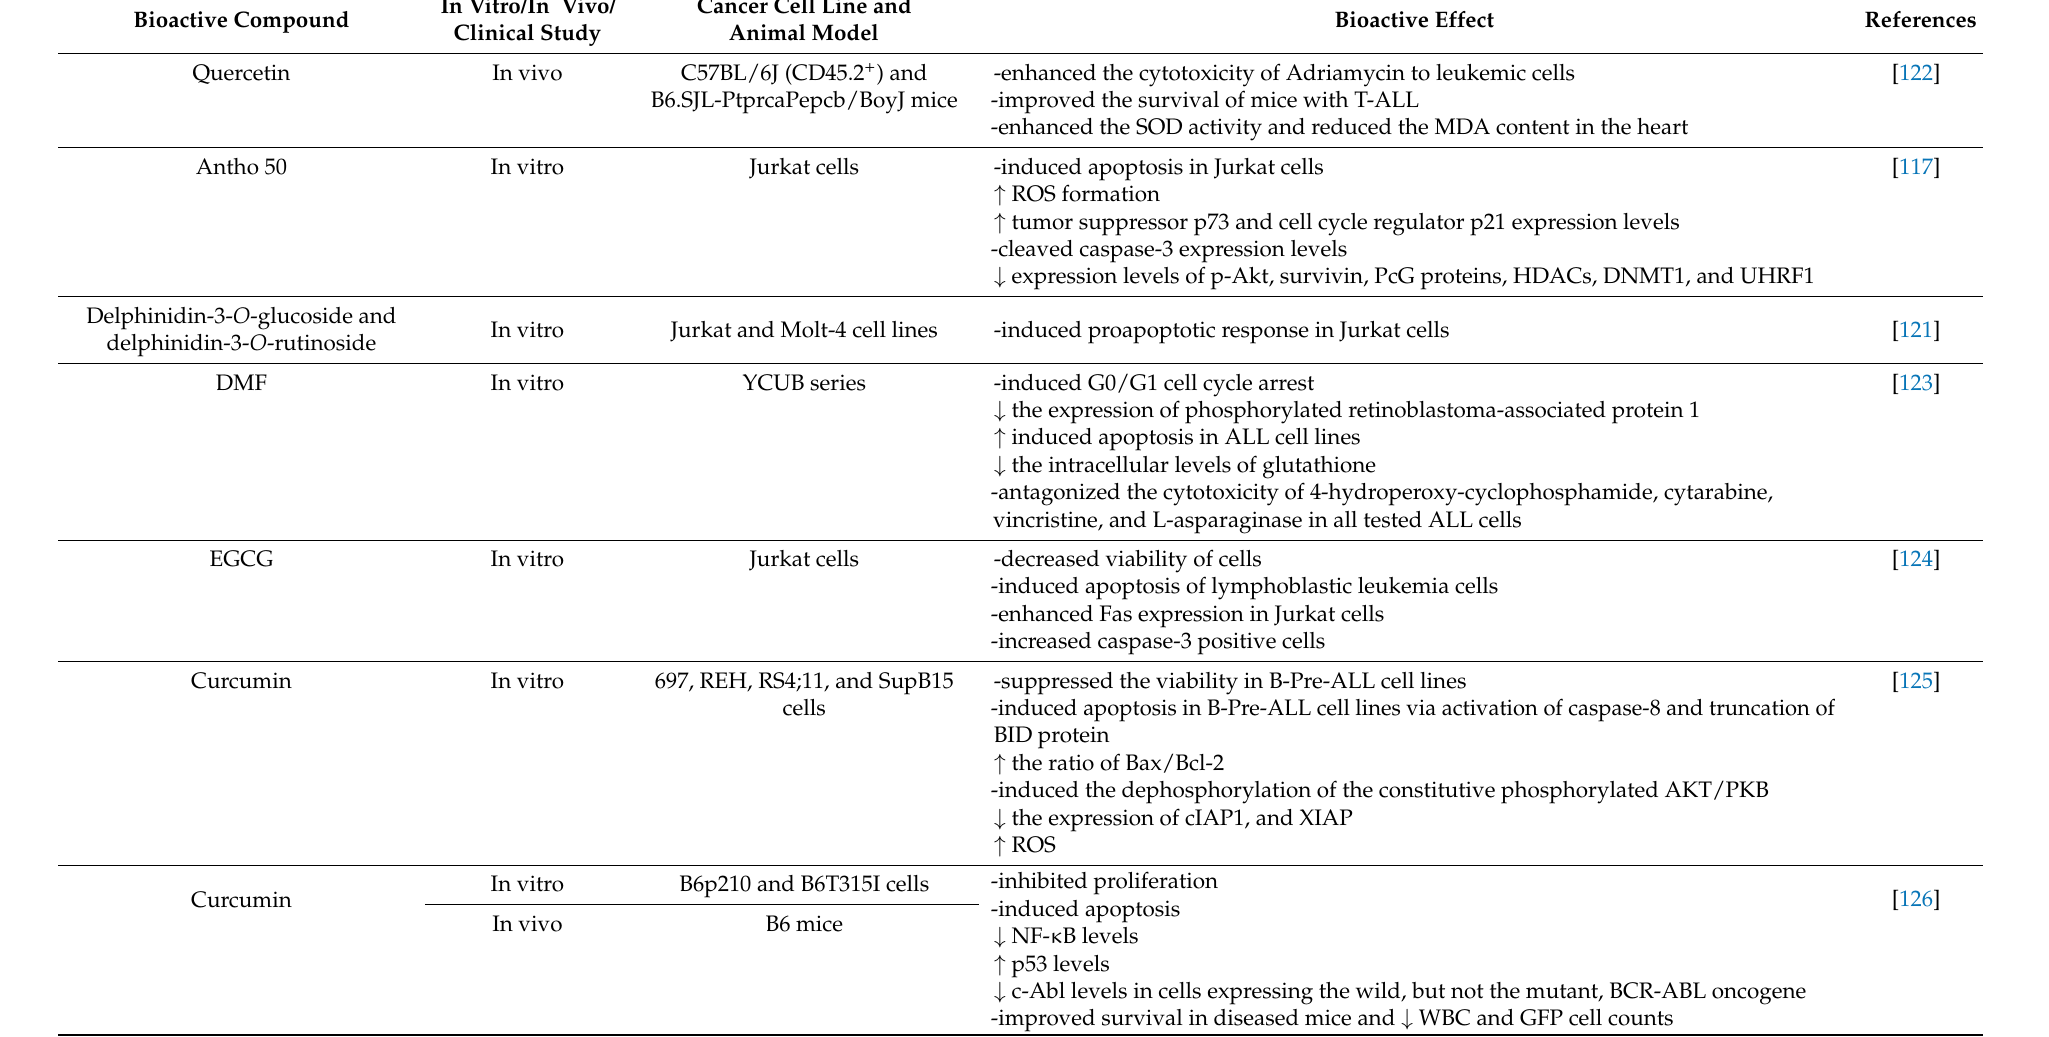
Table 3. Pharmacological effects of natural antioxidants in acute lymphoblastic leukemia